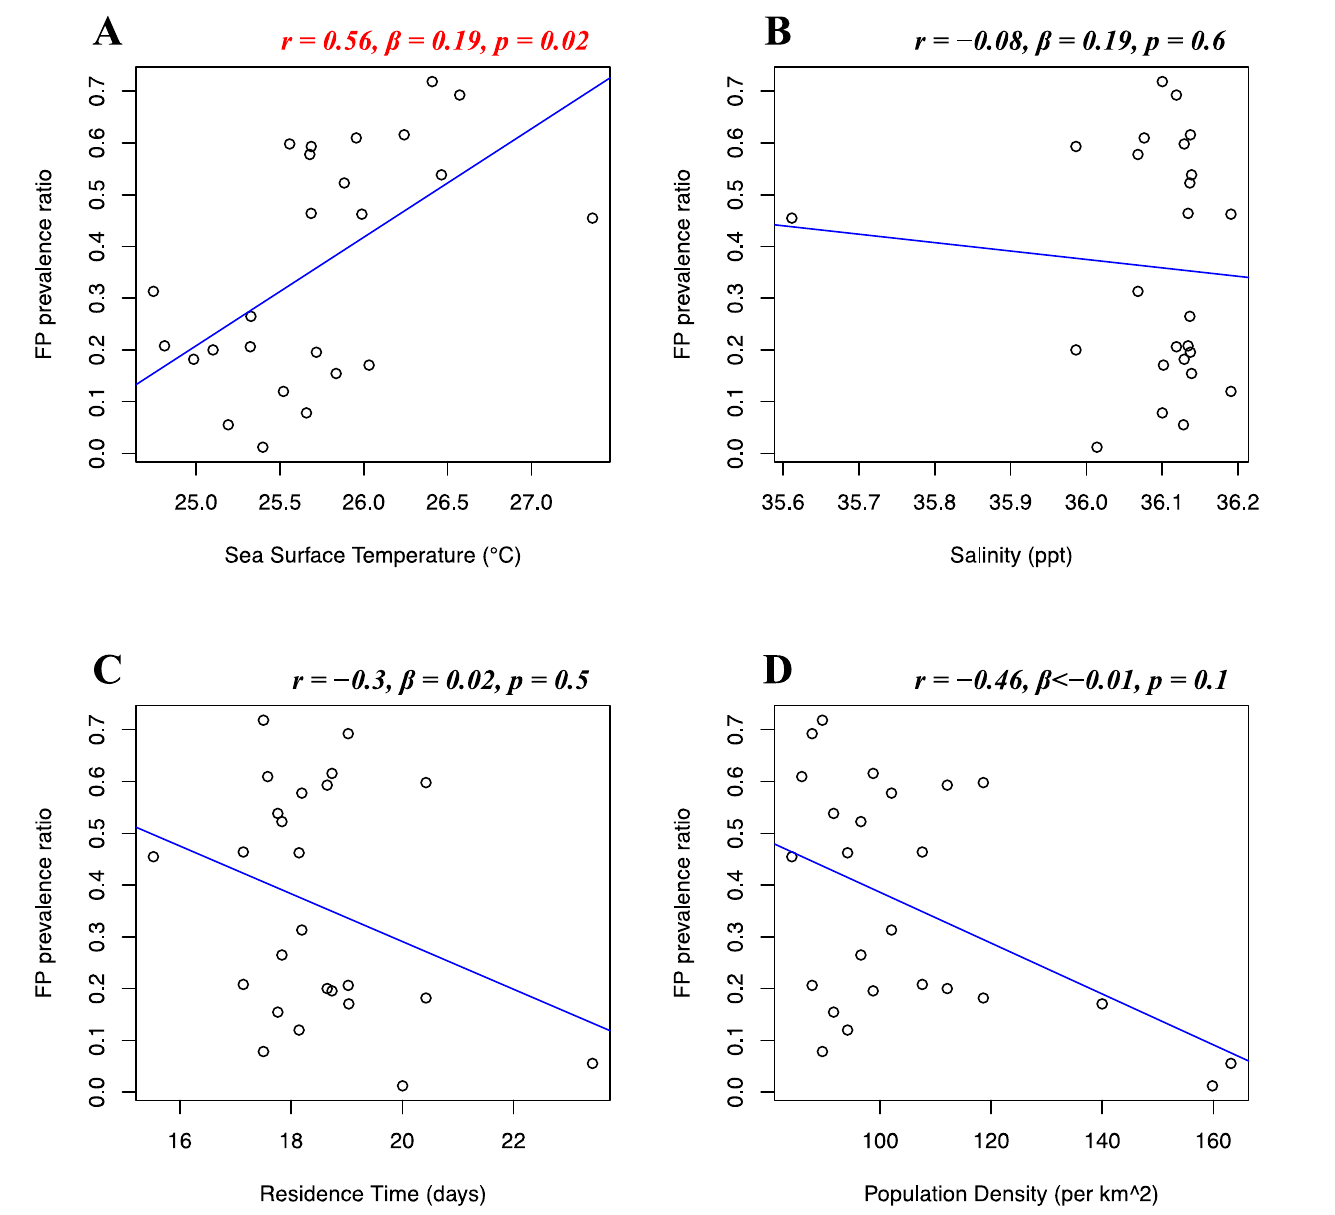
Figure 7. Florida in-water dataset FP prevalence and environmental and demographic variables. Scatterplots with fitted regression lines representing the logistic regression output from the response variables versus predictor variables in the Florida in-water dataset. The subplots show FP prevalence ratio on the y -axis versus sea surface temperature ( A ), salinity ( B ), residence time ( C ), and human population density ( D ) on the x -axis. Pearson correlation ( r ), beta-coefficient ( β ), and p -value ( p ) are reported for each predictor variable on the top right of the respective plot. Significant relationships are highlighted in red.